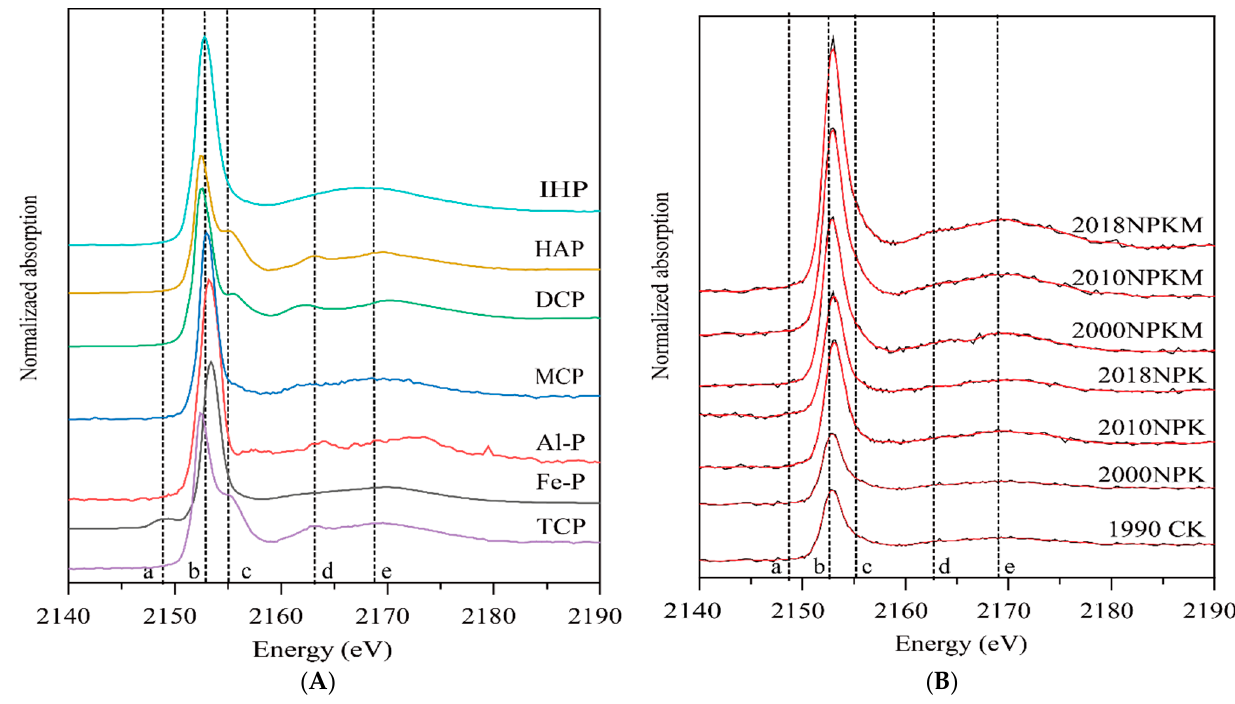
Figure 1. ( A ) The P K-edge XANES reference spectra of P standards; ( B ) The P K-edge XANES reference spectra of soil samples from long-term different P fertilization regimes. The red lines represent the LCF for the studied soil sample spectra ( B ). The dashed lines indicate spectral features for different P compounds. a Fe-P (2148.0 eV), b absorption edge (white line) (2153 eV), c,d Ca-P (2155.0–2162.5 eV) e oxygen oscillation (2169.0 eV). Al-P, aluminum phosphate (AlPO 4 ), Fe-P, iron phosphate dihydrate [FePO 4 · 2H 2 O], DCP, dibasic calcium phosphate (CaHPO 4 · 2H 2